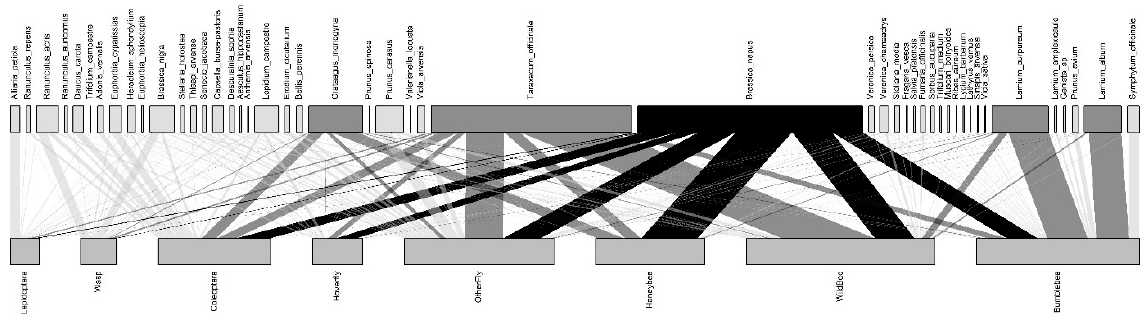
Figure 1. Bipartite network of plant–insect interactions. Plant species are on top and pollinator functional groups on bottom. The thickness of the bars indicates the total number of interactions. OSR and its interactions are black; the other four plants that share a high proportion of interactions with OSR are highlighted in dark grey.